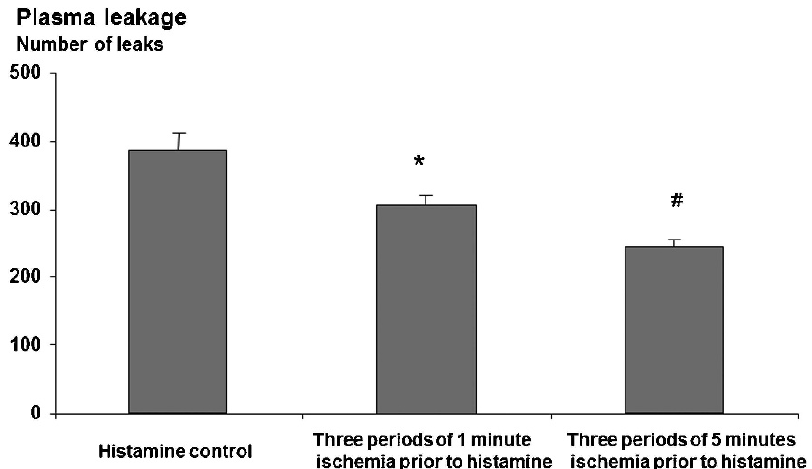
Figure 4 - Effect of brief periods of I/R prior to histamine application. Plasma leakage (maximal number of leaks ¡ SD) induced by histamine (2 m M). Three periods of 1 or 5 minutes of ischemia reduced the subsequent response to histamine. *= p , 0.05, # p , 0.01 as compared with histamine controls (2 m